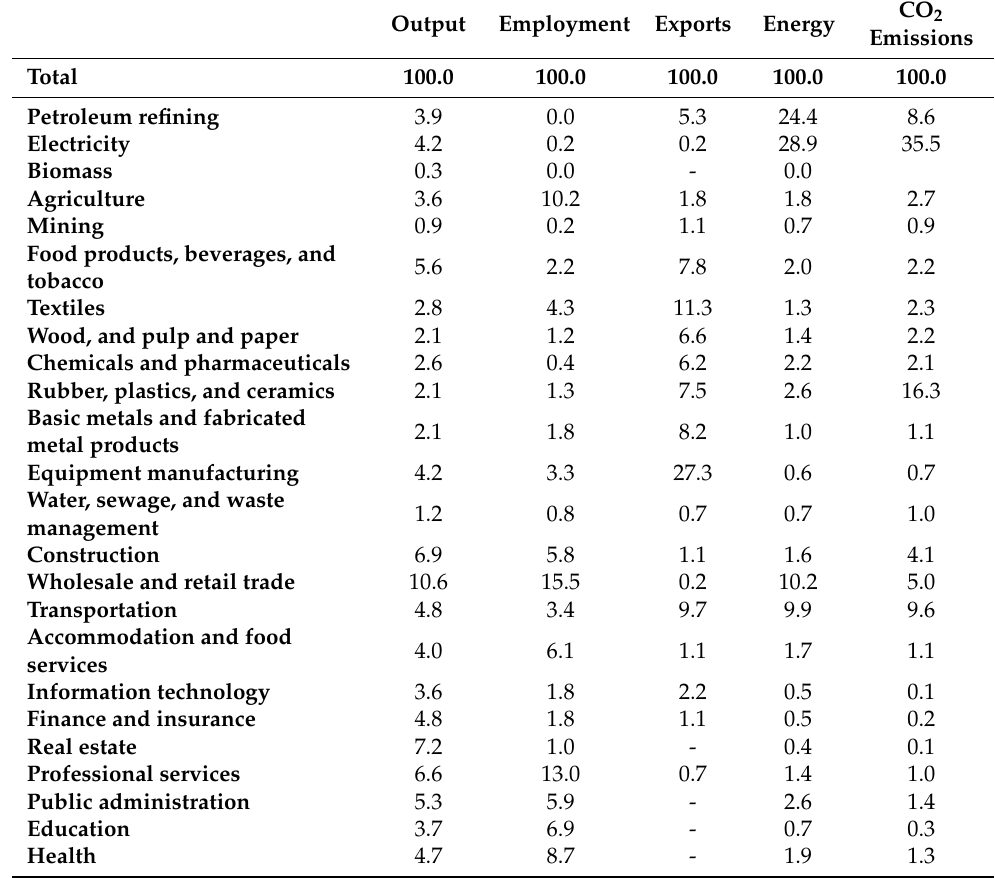
Table 1. Sectors of economic activity: definition and basic